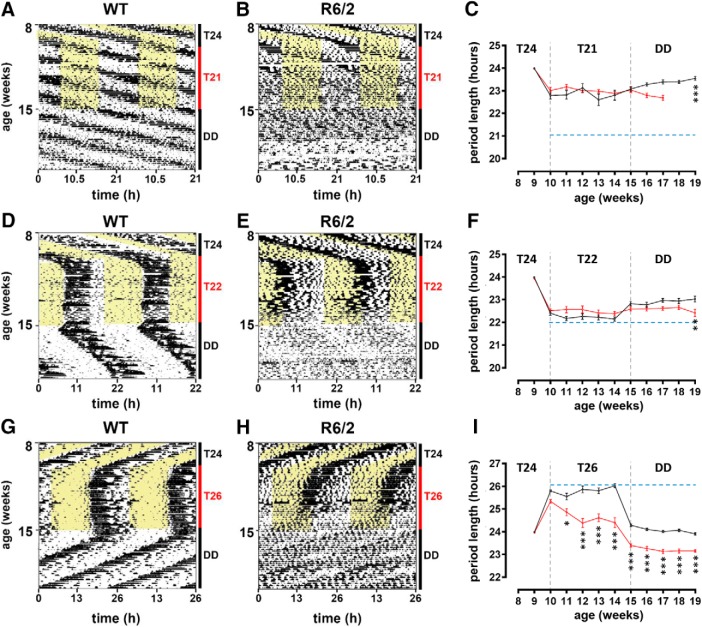
Rest–activity patterns of WT and R6/2 mice under T-cycles of 21, 22, and 26 h. A, B, D, E, G, H, Rest–activity profiles of WT mice (A, D, G) and R6/2 mice (B, E, H) placed under T24 then T21 (A, B), T22 (D, E), or T26 (G, H), and, finally, constant darkness. C, F, I, Graphs show the evolution of period length during the changes in light schedules. *p < 0.05; **p < 0.01; ***p < 0.001. C, F, I, The blue dotted line shows the time period of the light settings, or where the light had been set previously for the part of the plot where the mice were in DD.